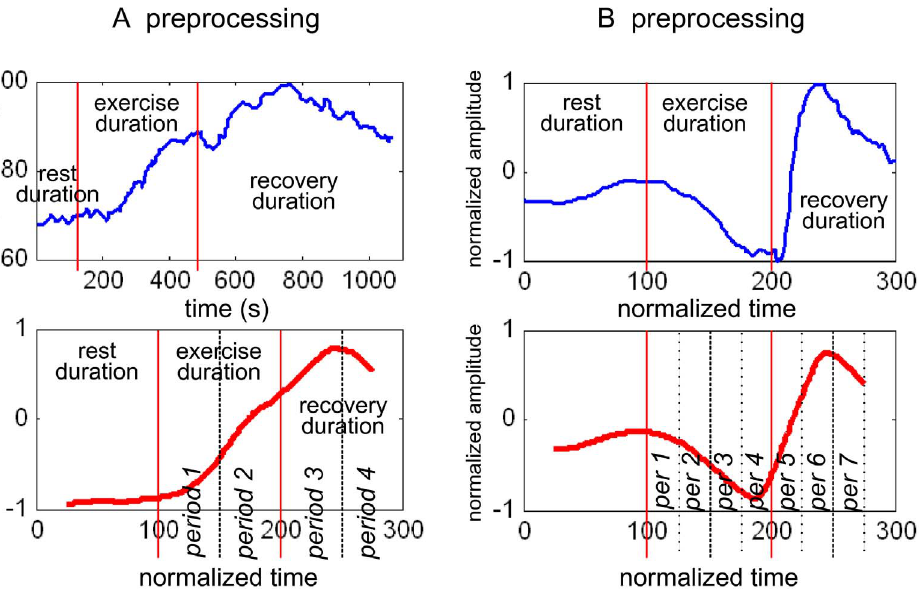
Figure 1. Preprocessing results. (a) The upper graph shows the original transcutaneous pO 2 signal. The lower graph shows the preprocessed transcutaneous pO 2 signal before clustering (second step) and the periods where the waveform is cut. (b) The upper graph shows the waveform of a cluster after the first step of the clustering. The lower graph shows the preprocessed waveform.